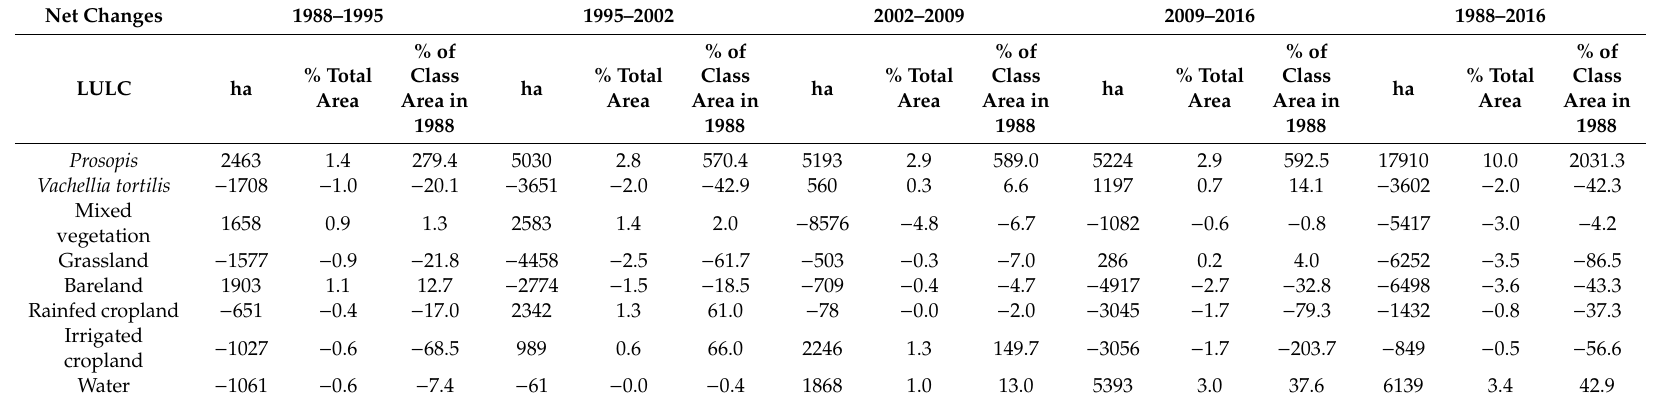
Table 4. The overall net changes of LULC in hectares (ha) and percent class shares of total study area and percent class shares of base class area in 1988. Changes